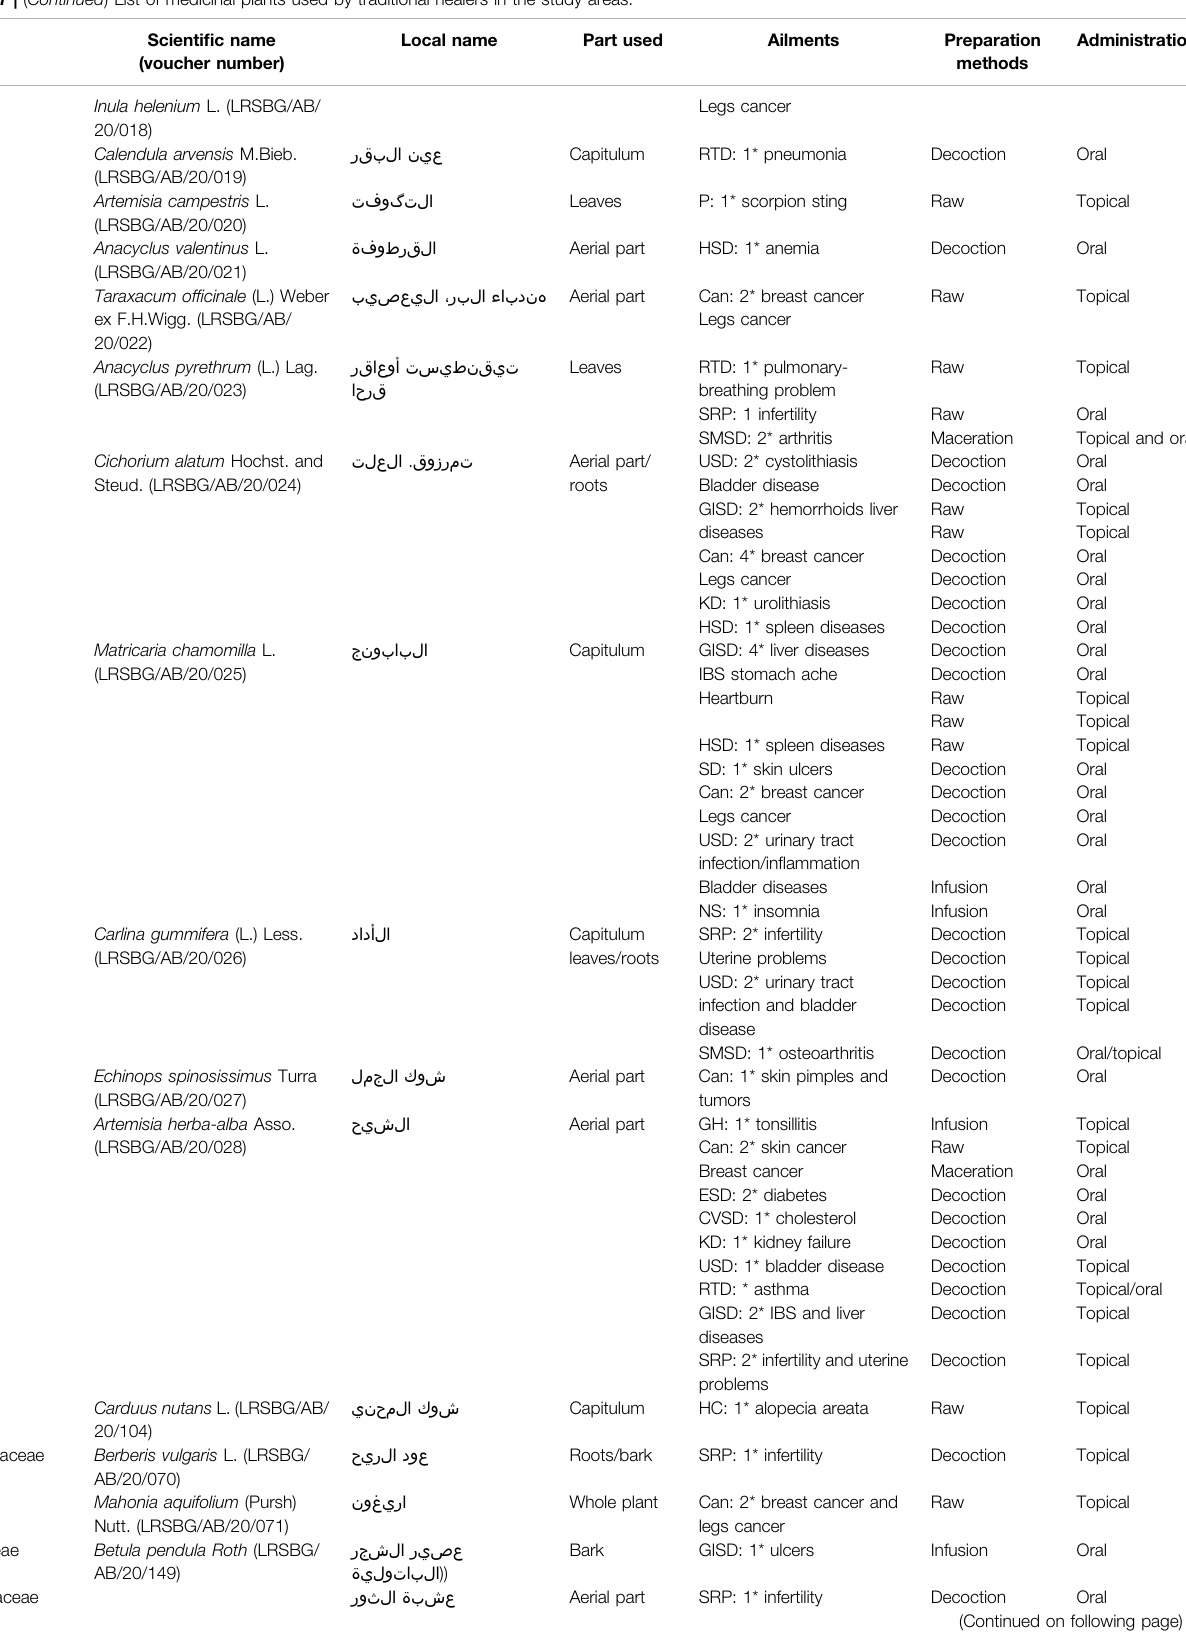
TABLE 7 | ( Continued ) List of medicinal plants used by traditional healers in the study areas.